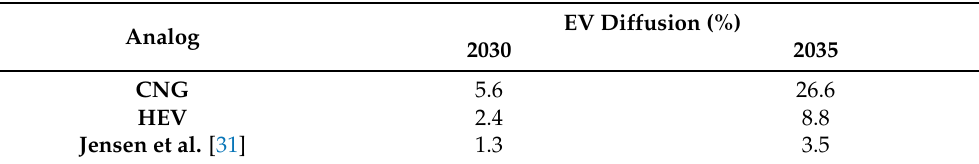
Table 4. Estimated EV diffusion at 2030 and 2035 in the city of Turin considering different analog